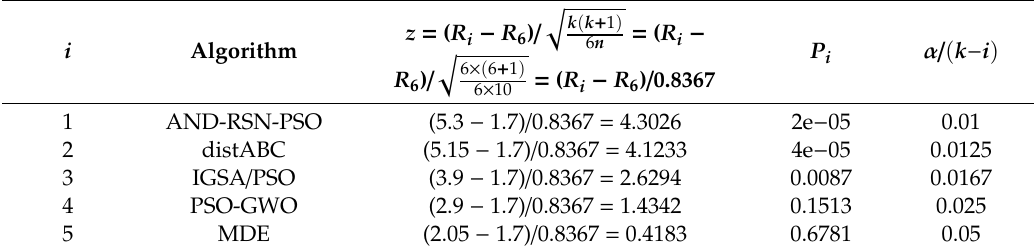
Table 10. The results of the Holm